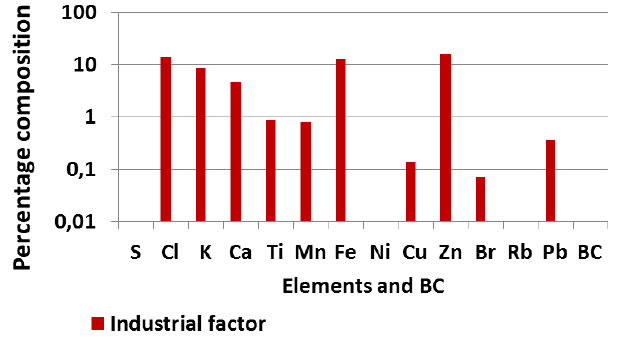
Figure 13. Seasonal variation of the five factors obtained from the PMF analysis of the PM 2 . 5 composition at the university site. The traffic factor shows consistency throughout the sampling period, highlighting the significance of vehicular emissions to urban air pol- lution. Seasons have been demarcated for